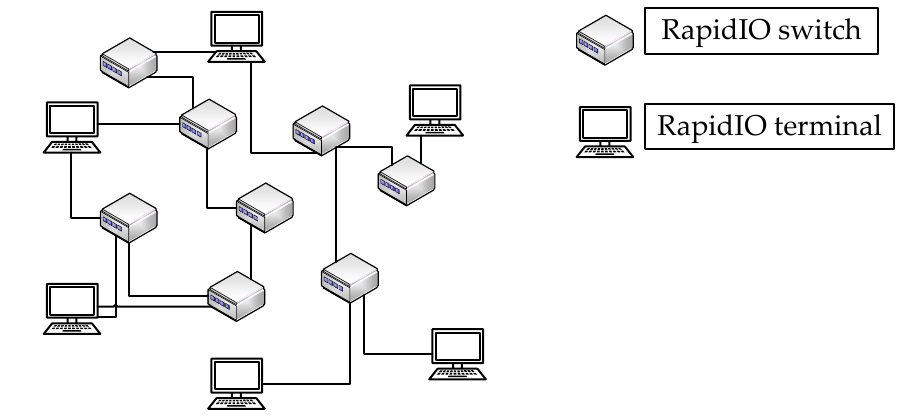
Figure 1. Topology of the RapidIO